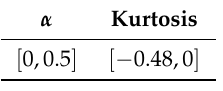
Table 1. Kurtosis values for BN ( α ) model.